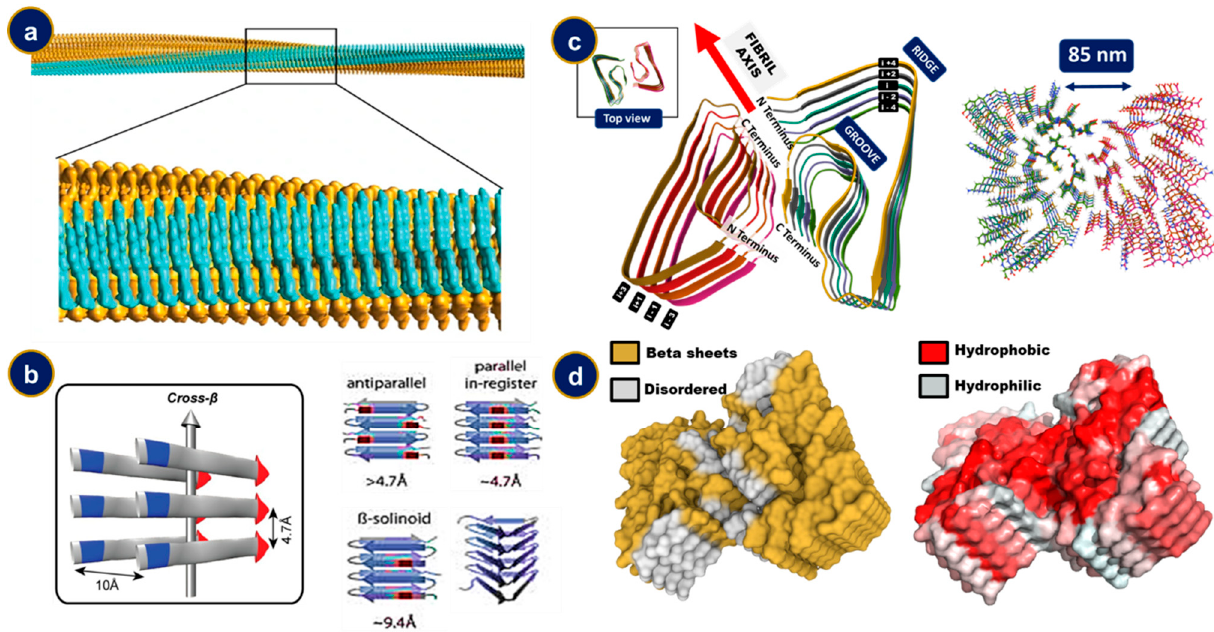
Figure 2. The structural features of amyloid fibrils: ( a ) 3D map of ATTR amyloid fibril constructed from cryo-EM image. Cyan depicts the N-terminus residue density and ochre depicts the C-terminus residue density (figure reproduced from [52]); ( b ) typical cross-beta-sheet motifs found in amyloids (the figure reproduced from [53]); ( c ) top and side views of the cartoon depiction of an amyloid fibril fragment showing the non-planar sub-units in a staggered conformation. The top view depicts a dry interface devoid of water formed due to interdigitation of the side chains of residues on opposite chains; ( d ) secondary structure and hydrophobicity mappings on the amyloid beta fibrils. The hydrophobic interactions in the core (red) bear testimony to its exceptional thermodynamic stability.